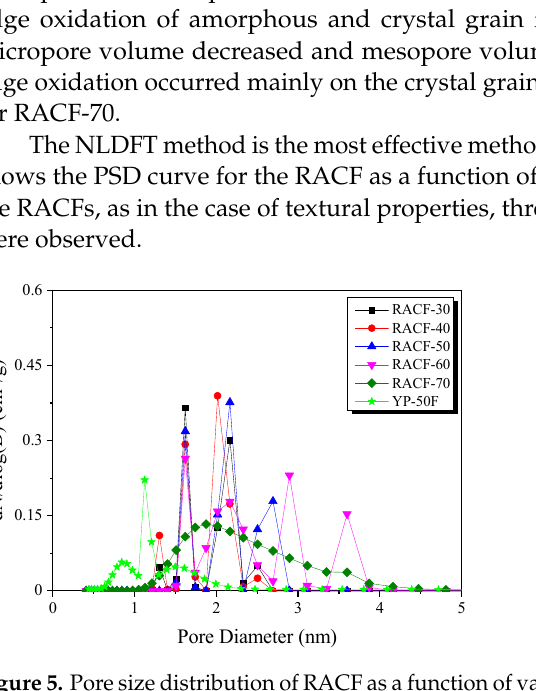
Figure 5. Pore size distribution of RACF as a function of various steam activation conditions according to the NLDFT equation.